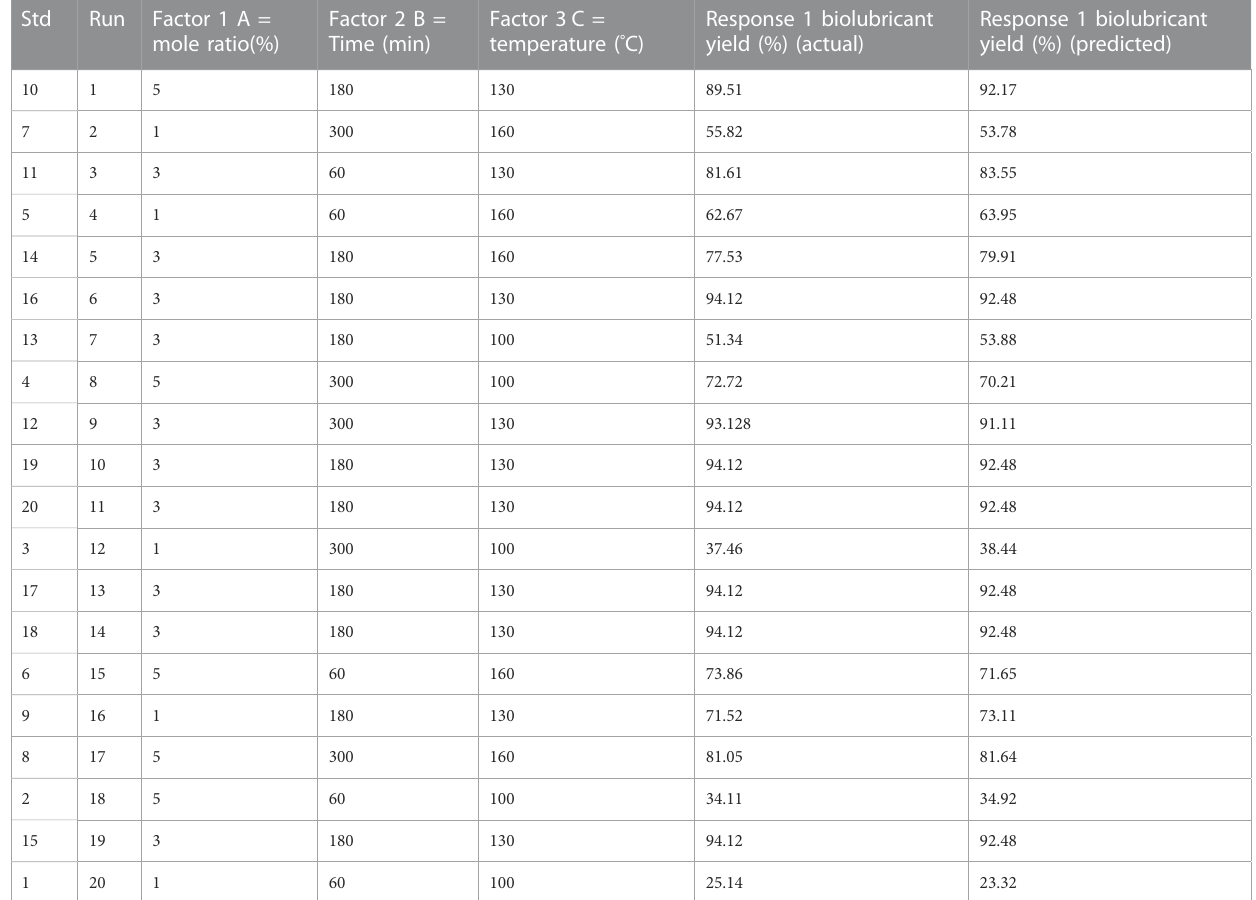
TABLE 6 Central composite design (CCD) of biolubricant production experiment. Std